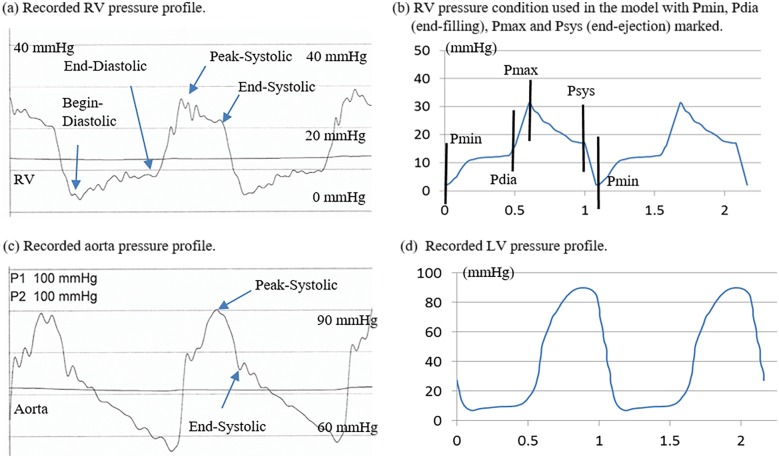
Recorded patient-specific pressure profiles and pressure conditions imposed on computational models.(a) Recorded RV pressure profile; (b) RV pressure condition used in the model with Pmin (begin-filling), Pdia (end-filling), Pmax, (begin-ejection) and Psys (end-ejection) marked; (c) recorded aorta pressure profile; (d) recorded LV pressure profile.